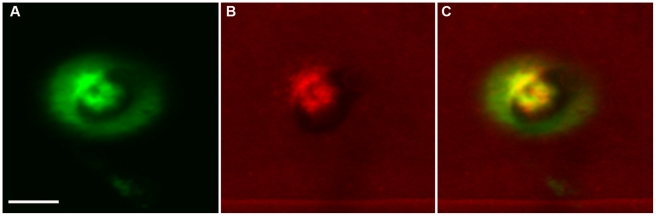
Two plant defense responses overlap when the
Δhyr1 mutant conidia were inoculated onto
leaves.Correlative images show plant reaction underneath appressoria 24 hpi. (A)
ROS staining; (B) aniline blue staining; (C) merged image of panels A
and B. Images were processed sequentially (ROS followed by aniline
blue), imaged by confocal microscopy and correlated. Scale bar
 = 2.5 µm.